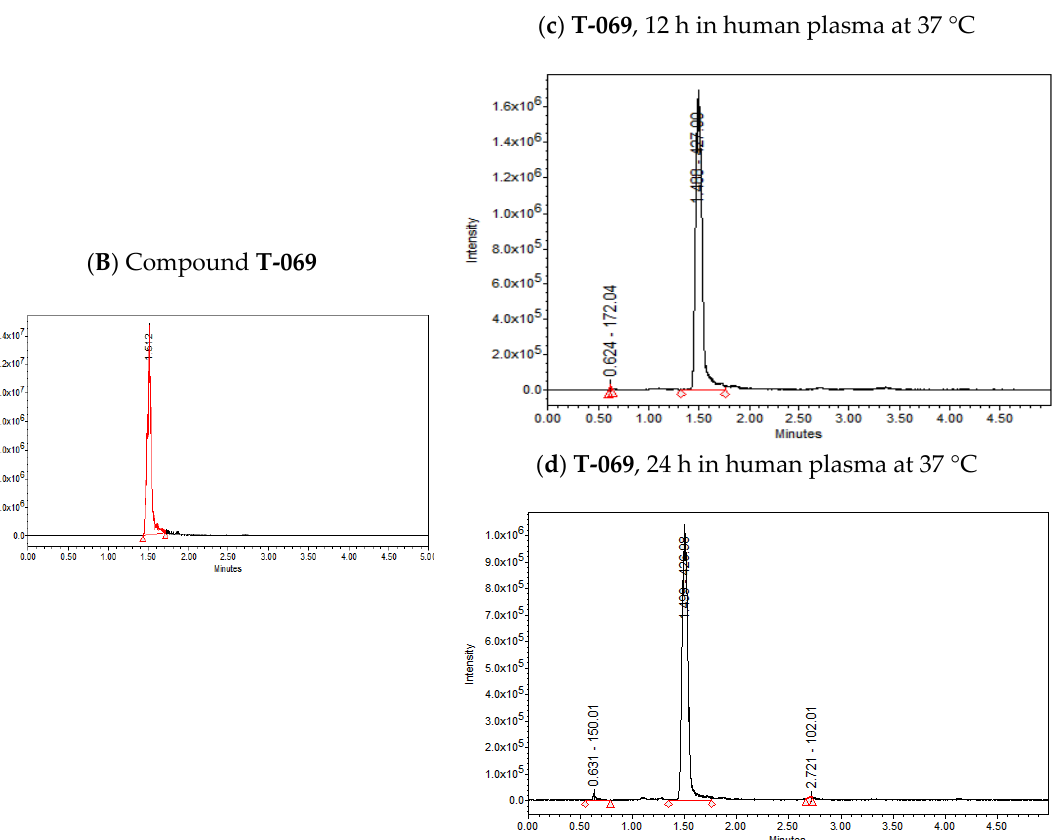
Figure 2. Ultra performance liquid chromatography (UPLC) of ( A ) compound T-018 and ( B ) compound T-069 . ( a ) T-018 after 12 h in human plasma at 37 °C; ( b ) T-018 after 24 h in human plasma at 37 °C; ( c ) T-069 after 12 h in human plasma at 37 °C; and ( d ) T-069 after 24 h in human plasma at 37 °C.